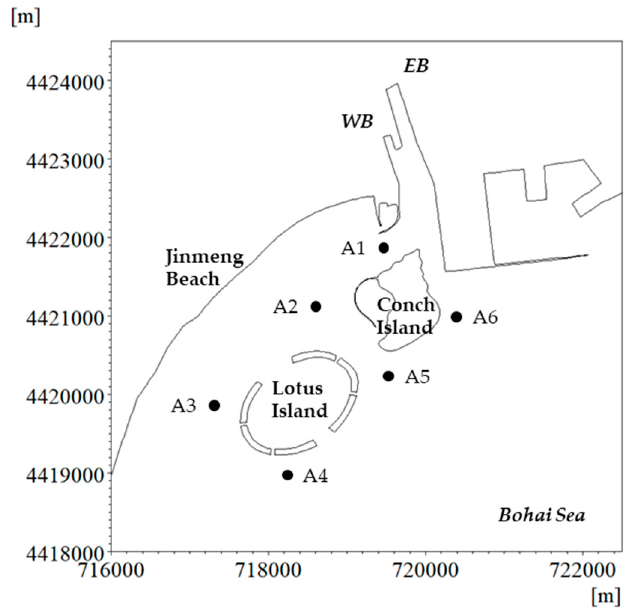
Figure 13. Locations of representative six sites.